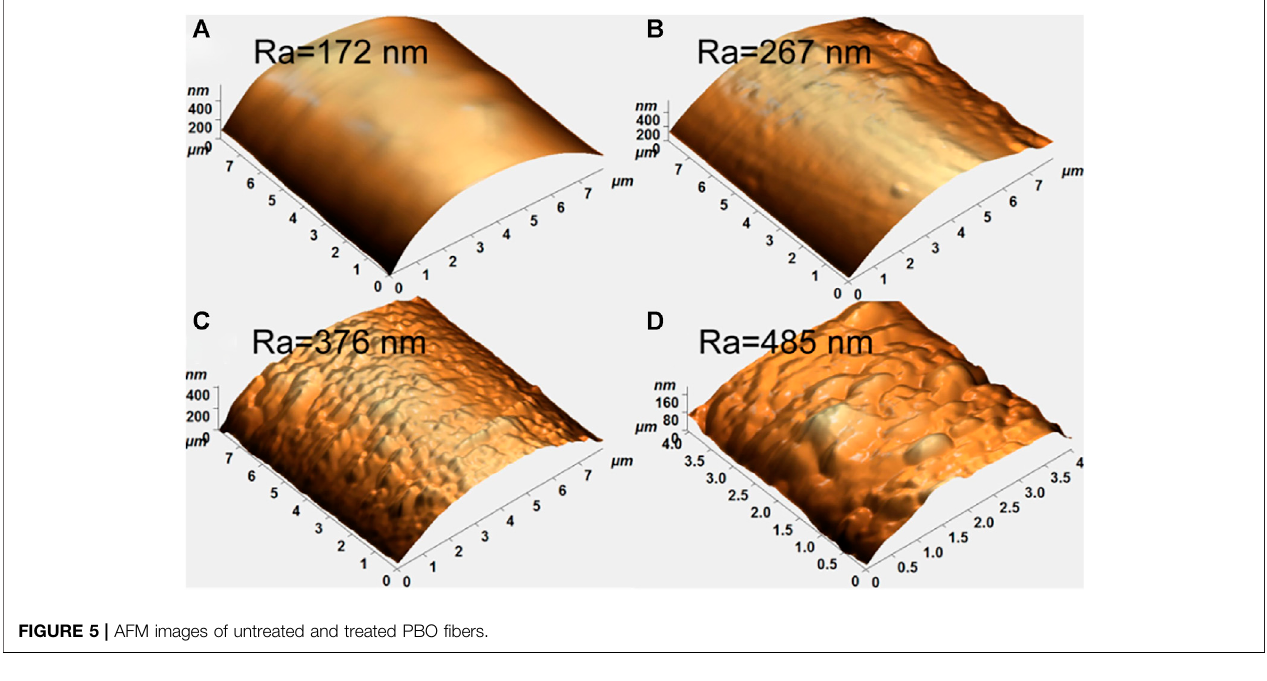
FIGURE 5 | AFM images of untreated and treated PBO fi bers.